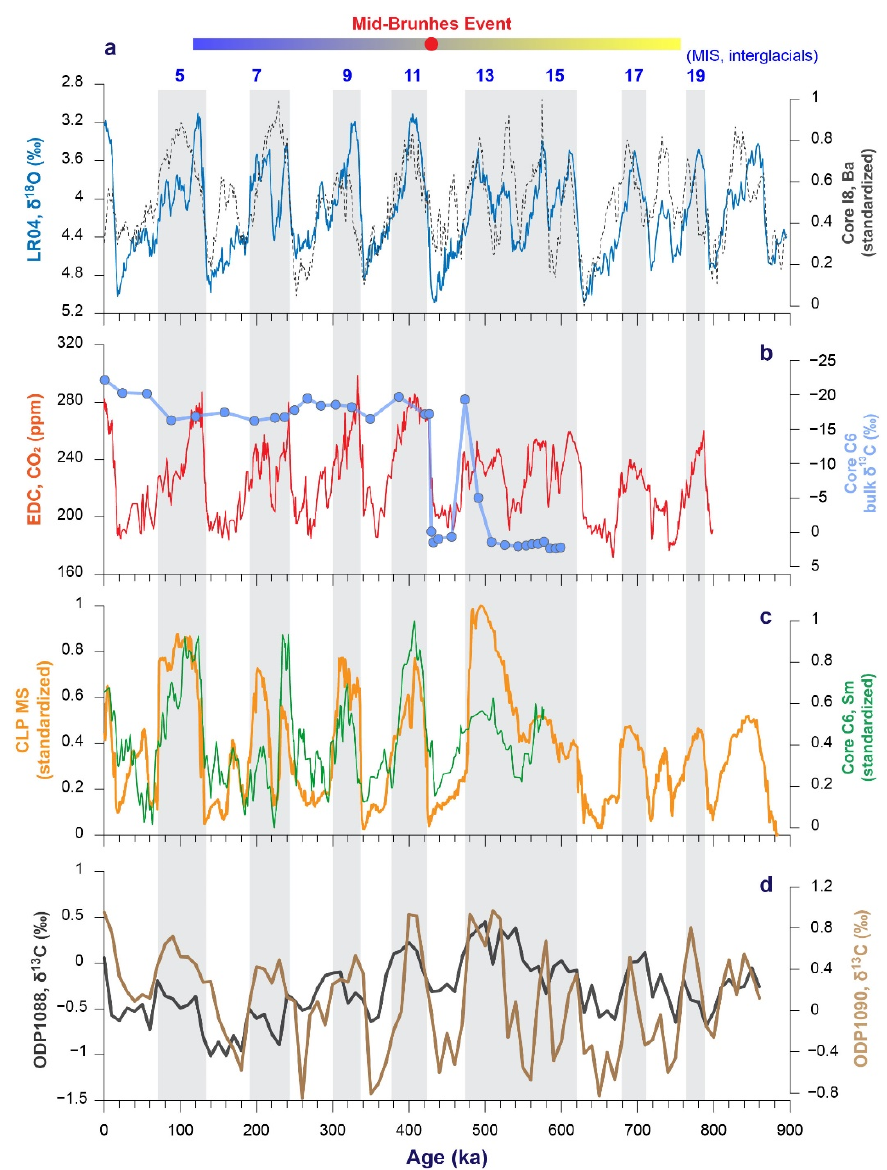
Figure 5. Comparison of various environmental proxies. ( a ) Benthic δ 18 O stack LR04 [2] versus the element Ba of core I8; MIS, marine isotope stages, which are labelled as numbers 5–19 on the top; ( b ) EPICA Dome C ice core CO 2 [6] versus the bulk carbon δ 13 C of core C6; ( c ) stack magnetic susceptibility (MS) of Chinese Loess Plateau (CLP) [44], versus the element Sm of core C6; ( d ) Benthic δ 13 C records of ODP Sites 1088 and 1090, indicating changes in Circumpolar Deep Water [55] .